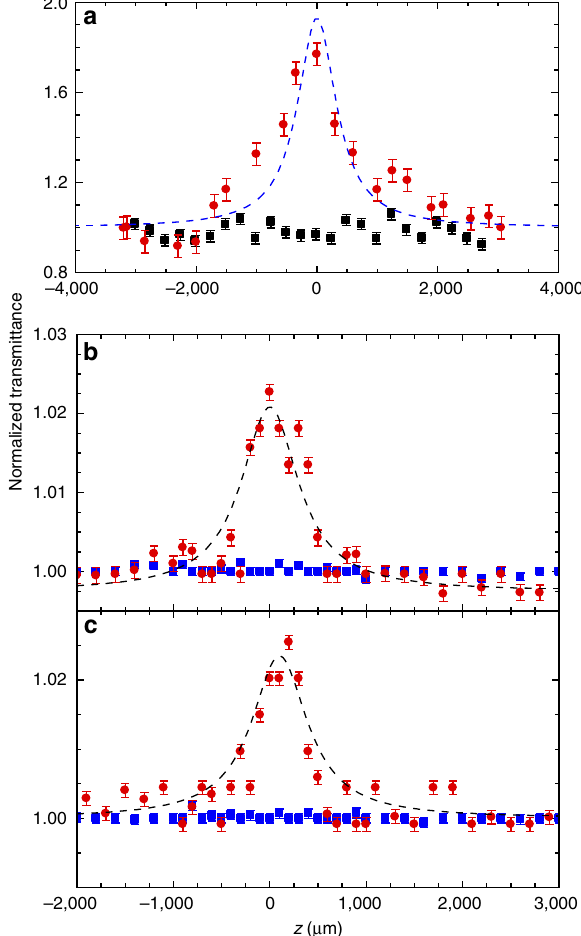
Figure 8 | Transparency modulation. ( a – c ) z -scan normalized transmittance traces of ( a ) water-based graphene saturable absorber (W-GSA) (dots) and ( b , c ) ethanol-based graphene saturable absorber (Eth-GSA) probed with a quantum cascade laser operating at ( b ) 10% duty cycle, and ( c ) 20% duty cycle, compared with the z -scan normalized transmittance traces of the Si/SiO 2 substrate (squares). The error bars correspond to the uncertainty interval on the measured normalized transmittance. The dashed lines are the fits with equation